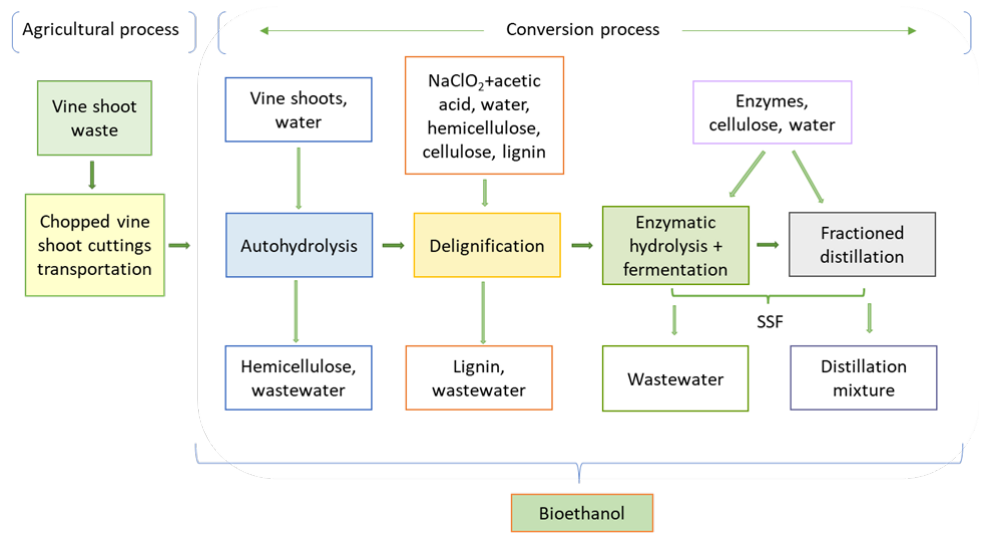
Figure 1. System boundary for the vine shoot waste to bioethanol scenario.